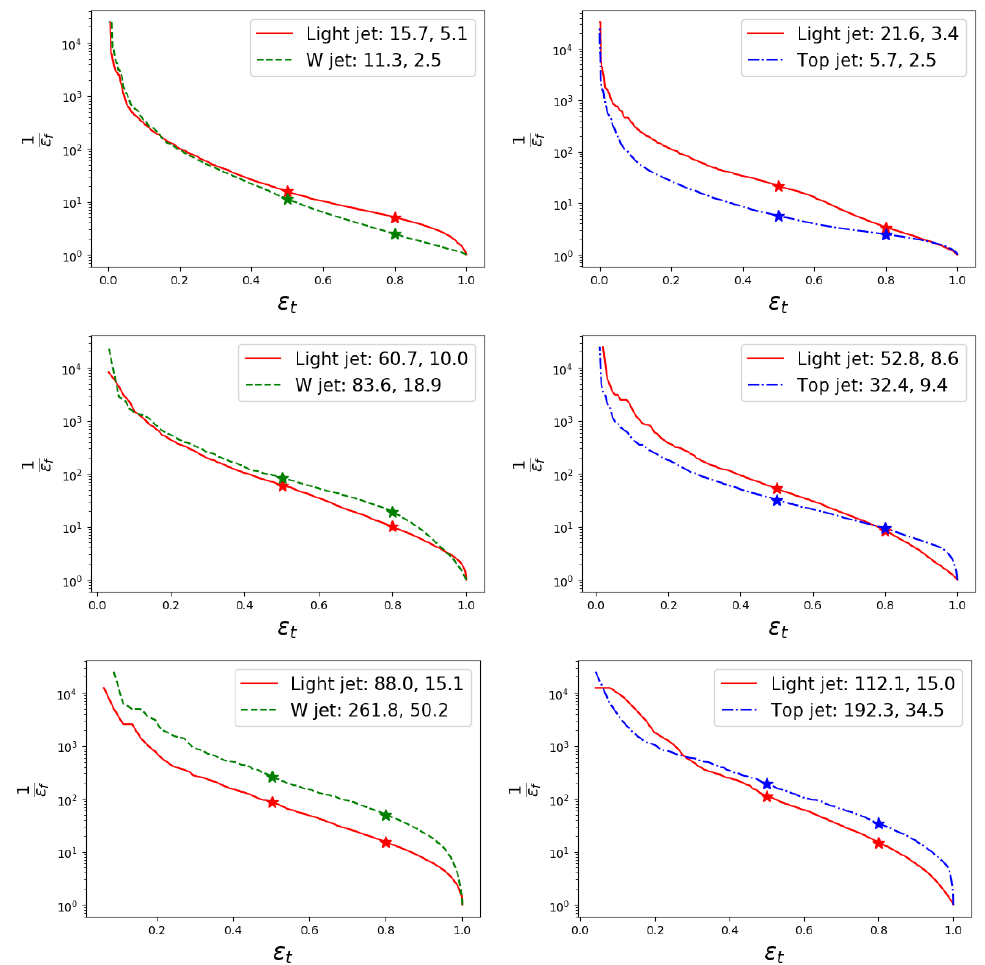
Figure 7 . The ROC curves for tagging a top (left column) against a light jet (red straight) or W (green dash); or for tagging a W boson (right column) against a light jet (red straight) or top (blue dash point), for p T ranges are [200, 400] GeV, [400, 800] GeV and > 800 GeV for the upper, middle and lower rows. The x axis is (cid:15) t and y axis is 1 , which (cid:15) t is the \true rate" and (cid:15) f is the (cid:15) f \mistagging rate". Benchmark points with top tagging rates of 0.5 and 0.8 are indicated on each curve, with the corresponding (cid:15) f